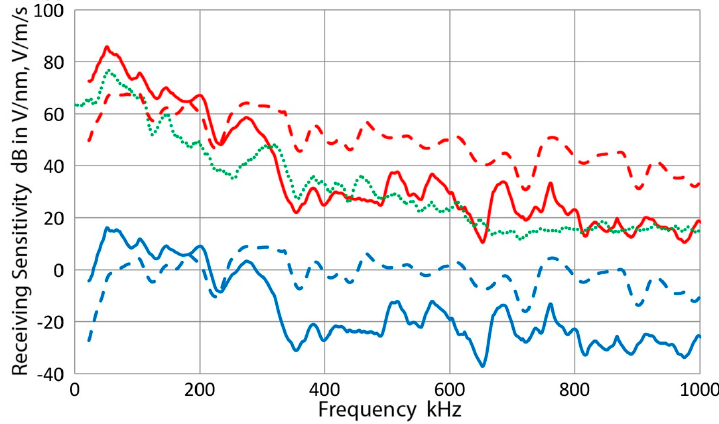
Figure 11. Receiving sensitivity of PAC R6a (AI06). The displacement receiving sensitivities are shown in blue curves and velocity sensitivities are in red. Solid lines are for the bar-wave data, while dashed curves are for the sensitivities to normally incident waves. Green curve is the velocity calibration for surface waves from PAC.